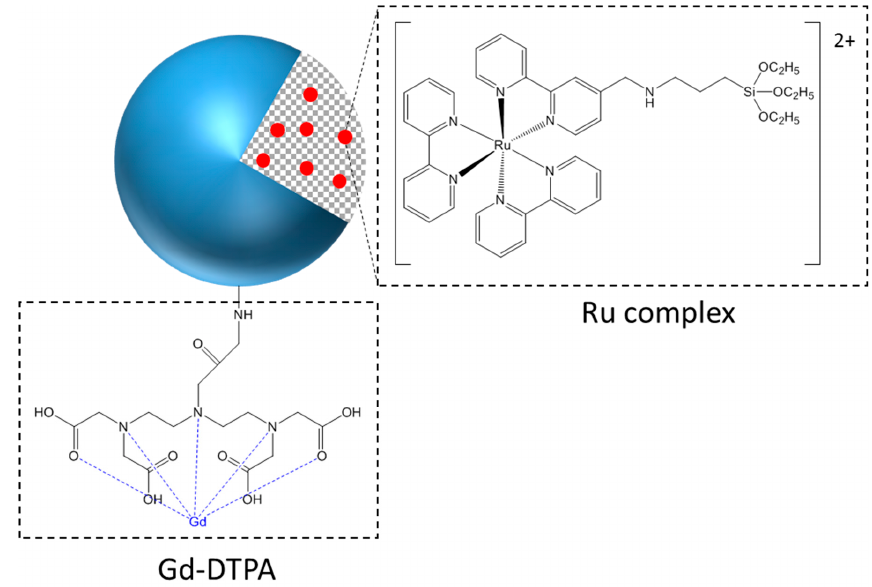
Figure 9. Schematic representation of a LumiLys 650 NP functionalized with Gd-DTPA (Gadolinium- DiethyleneTriaminePentaacetic Acid).